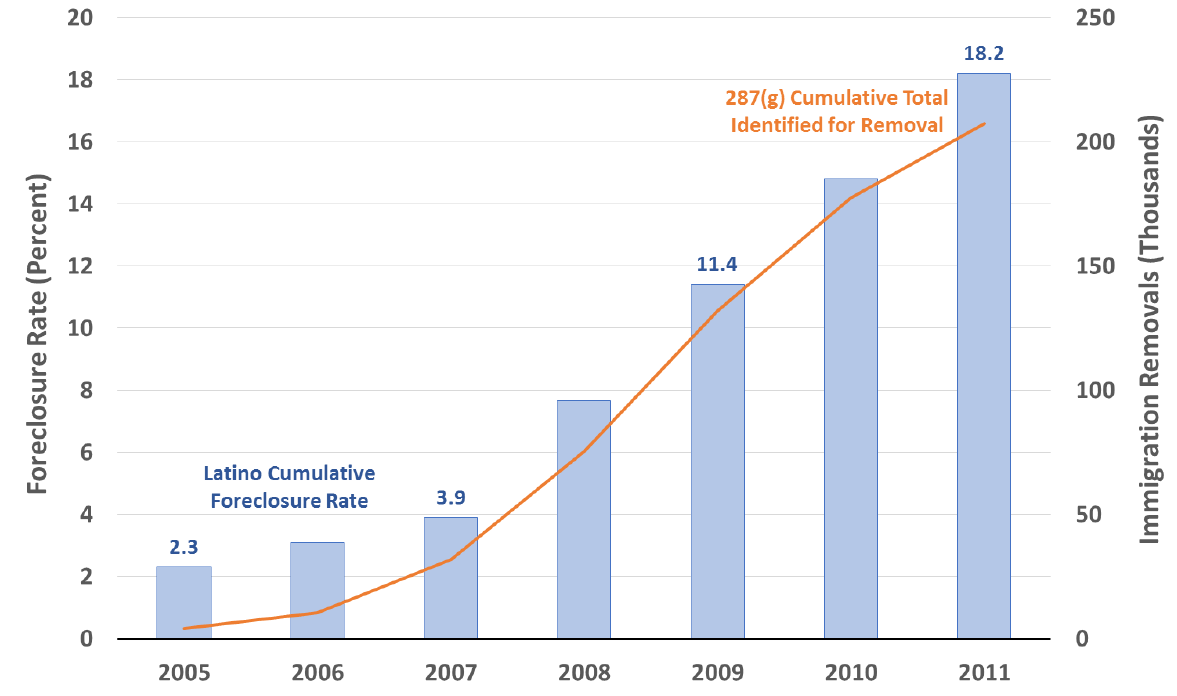
Figure 1: Latino foreclosure rate and local 287(g) immigrant enforcement, 2005–2011. Sources: Hall, Crowder, and Spring (2015b); Immigration and Customs Enforcement